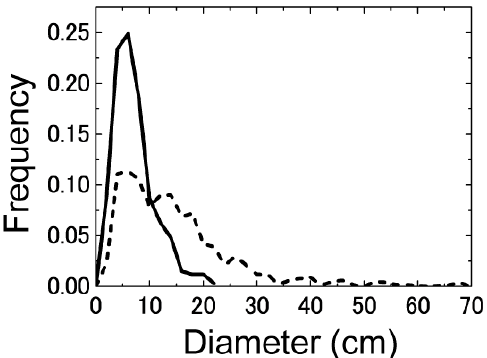
Figure 3. The particle diameter of snow avalanche deposit. The solid line shows the graph of a dry snow avalanche and the dotted line shows a wet avalanche. Both graphs show a peak in the 0–10 cm range [33].